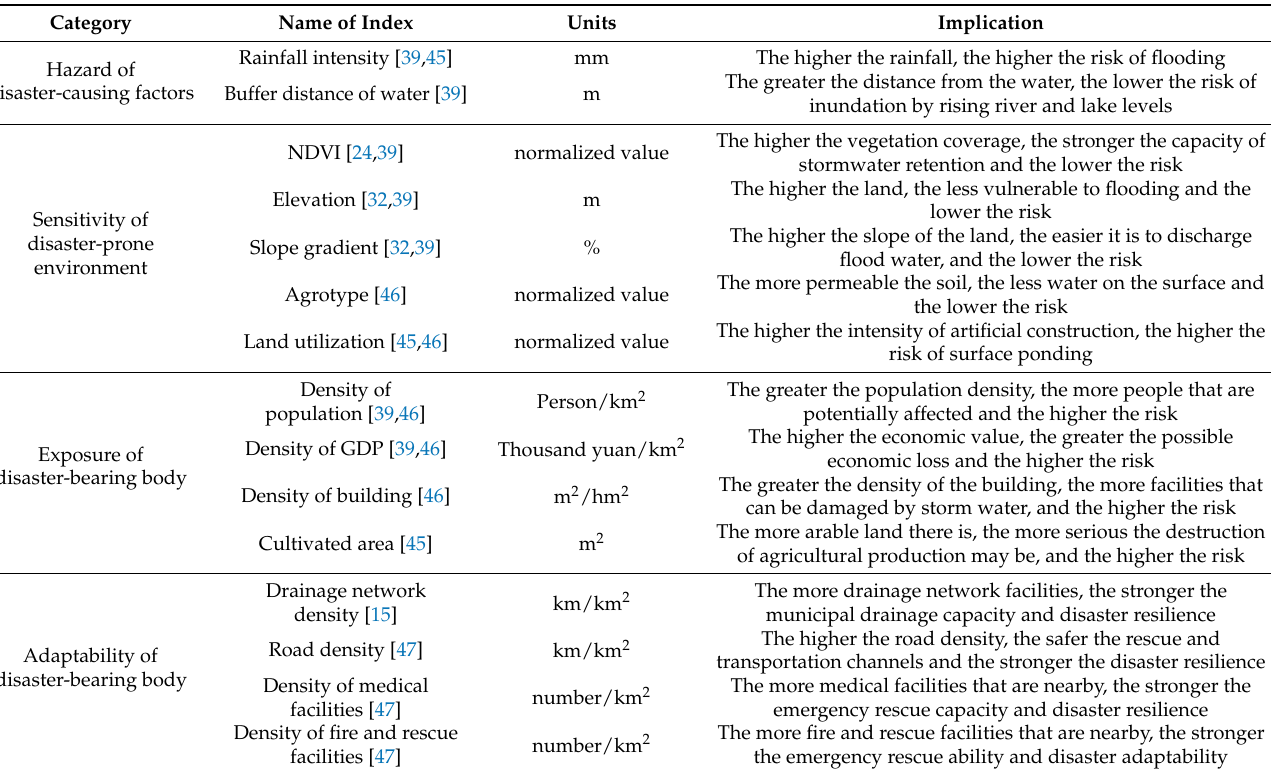
Table 2. Assessment index system of regional demand for